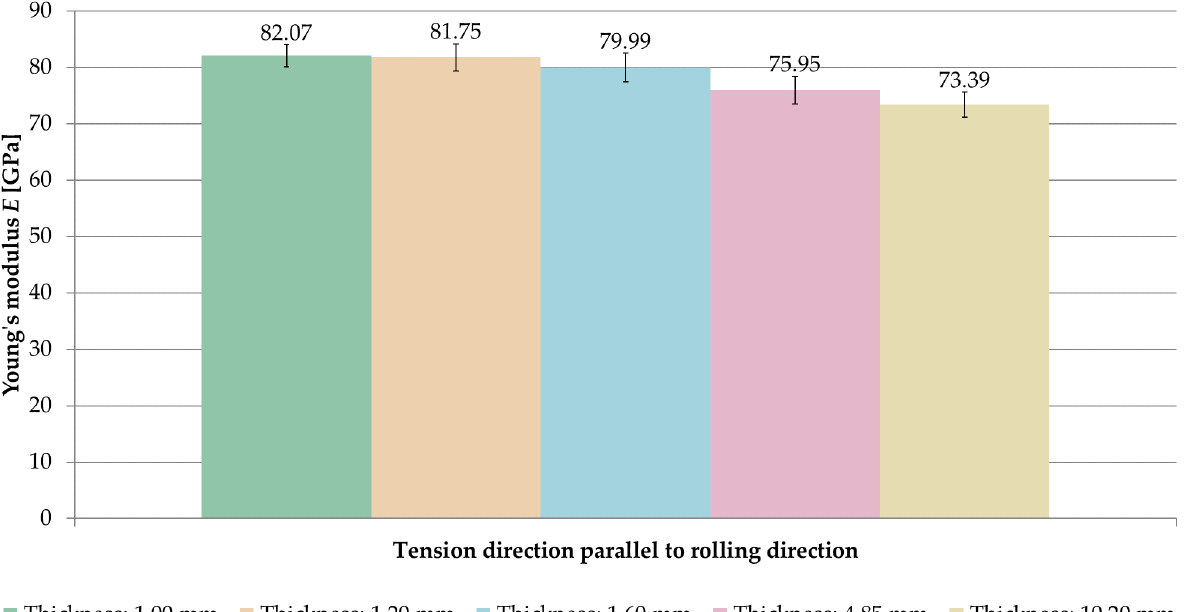
Figure 7. Comparison of Young’s modulus E for samples stretched parallel to the rolling